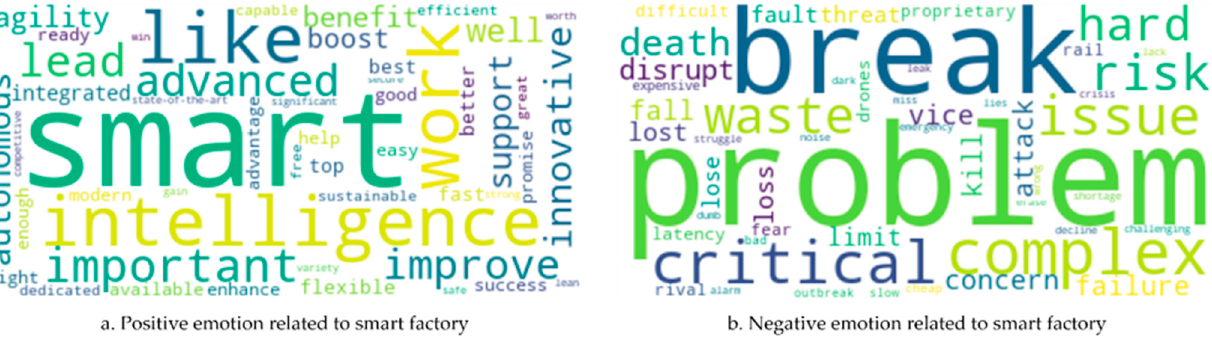
Figure 3. Word clouds of the emotions extracted from the news articles on smart